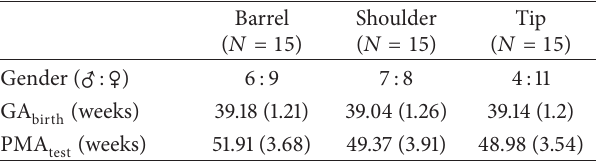
Table 1: Characteristics of study